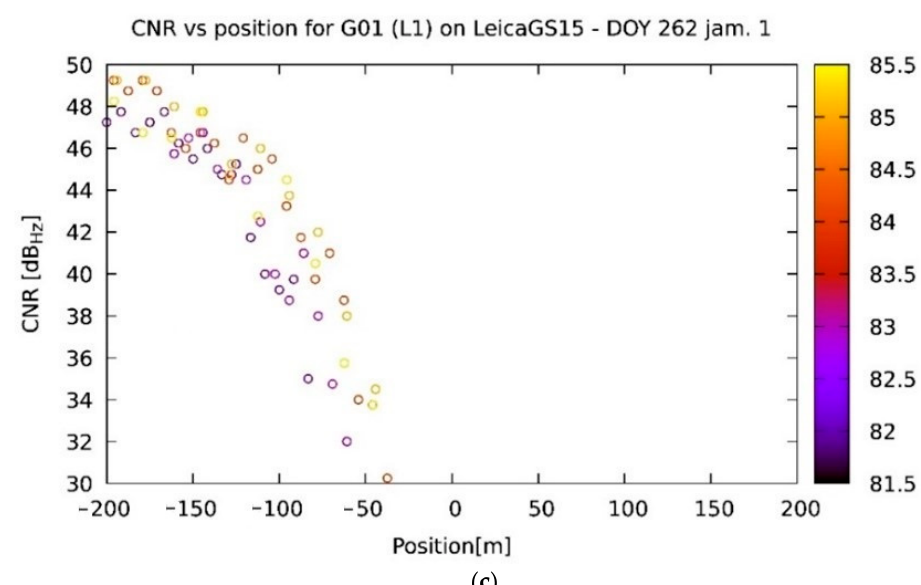
Figure 11. CNR dependence on the position of the jammer on the road (0 is the point closest to the receiver, a negative value means the jammer is approaching, and a positive value that it is distancing): ( a ) typical behavior for a smartphone receiver; ( b ) typical behavior for a Leica GS18; and ( c ) typical behavior for a Leica GS15. The color of the points represents the satellite elevation.